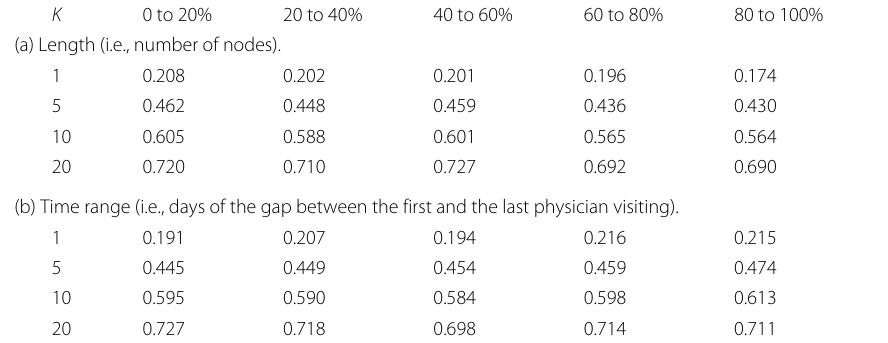
Table 4 The BPR-IW recall of five groups of information walks with several K on 07/01/2011 K 0 to 20% 20 to 40% 40 to 60% 60 to 80% 80 to 100% (a) Length (i.e., number of nodes). 0.208